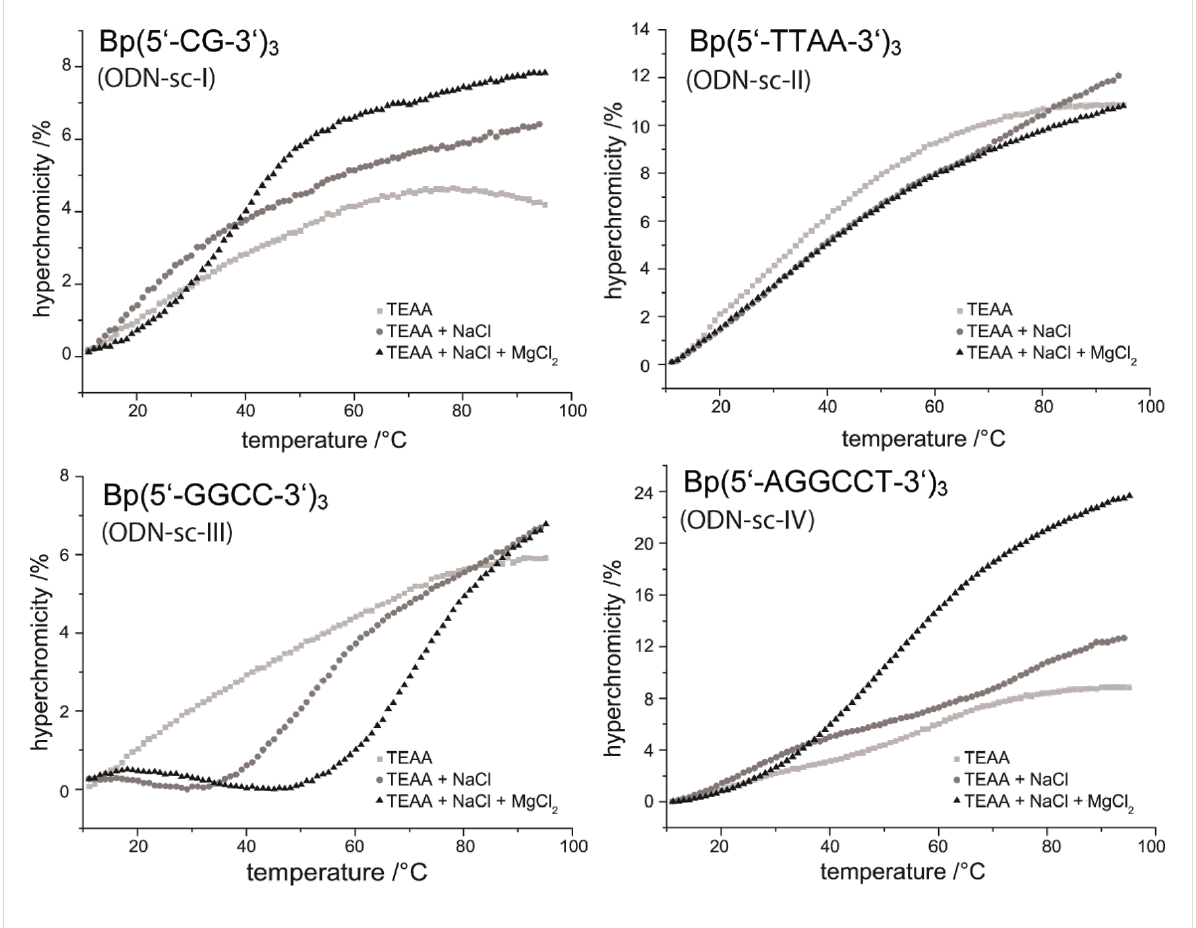
Figure 2: Thermal denaturating studies of self-complementary branched oligonucleotides. Different conditions are indicated in the figure. TEAA: triethylammonium acetate.